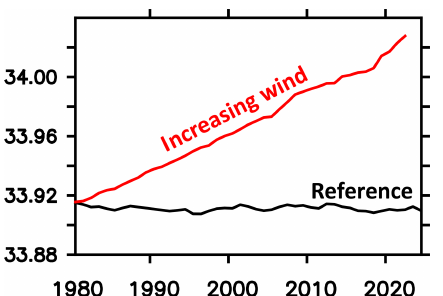
Figure 18. Observed sea surface salinity averaged over the Southern Ocean (i.e., south of 40 ◦ S) based on Argo data (Roemmich and Gilson,